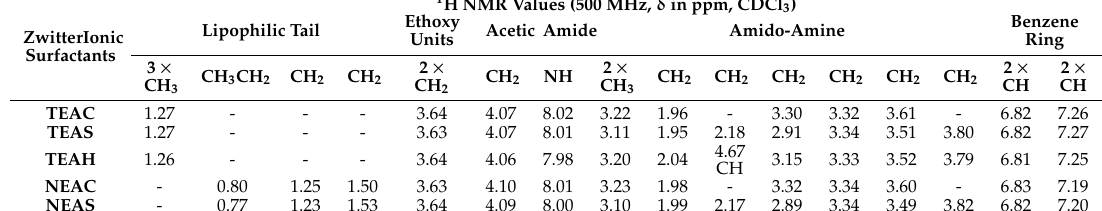
Figure 1. Carbon-13 Nuclear Magnetic Resonance (NMR) of the intermediate compound ( 5 ).